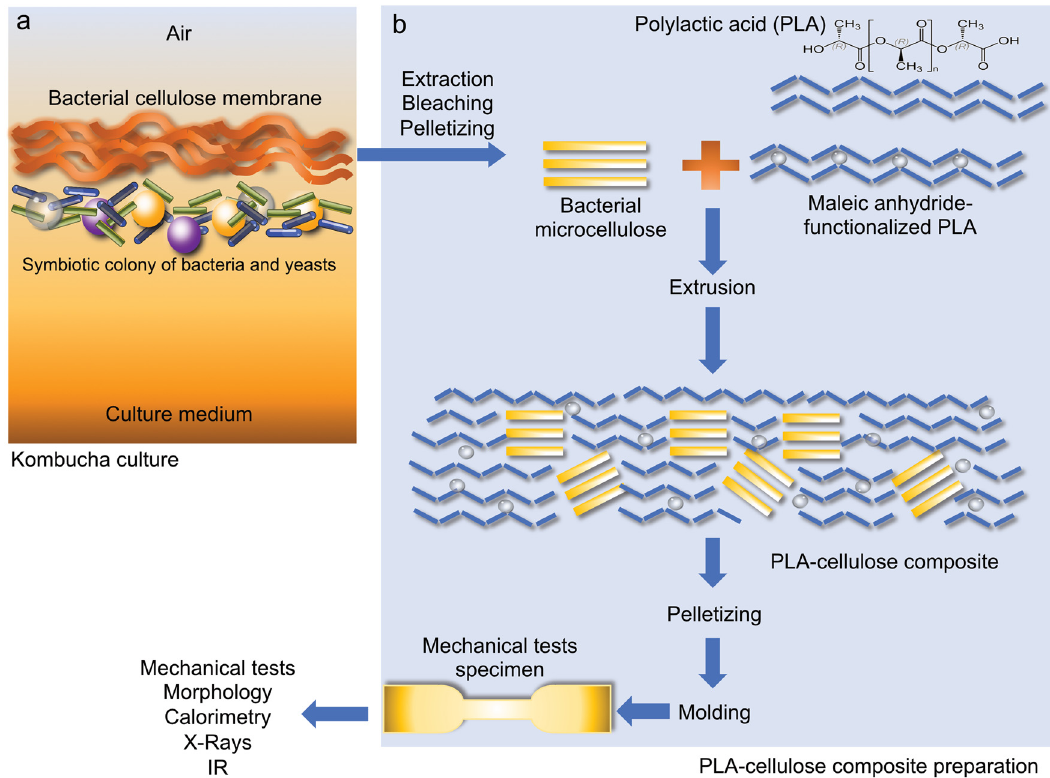
Figure 1: Preparation of the PLA – cellulose composites: ( a ) production of bacterial cellulose by the bacterial members of the kombucha symbiotic colony, ( b ) preparation of the composites and their molding into a mechanical tests specimen for